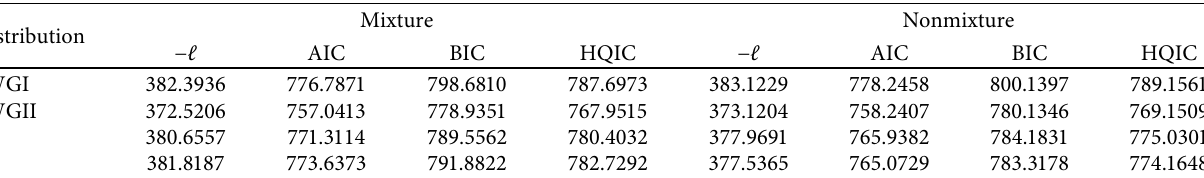
Table 10: Goodness-of-fit measures of fitted regression models.